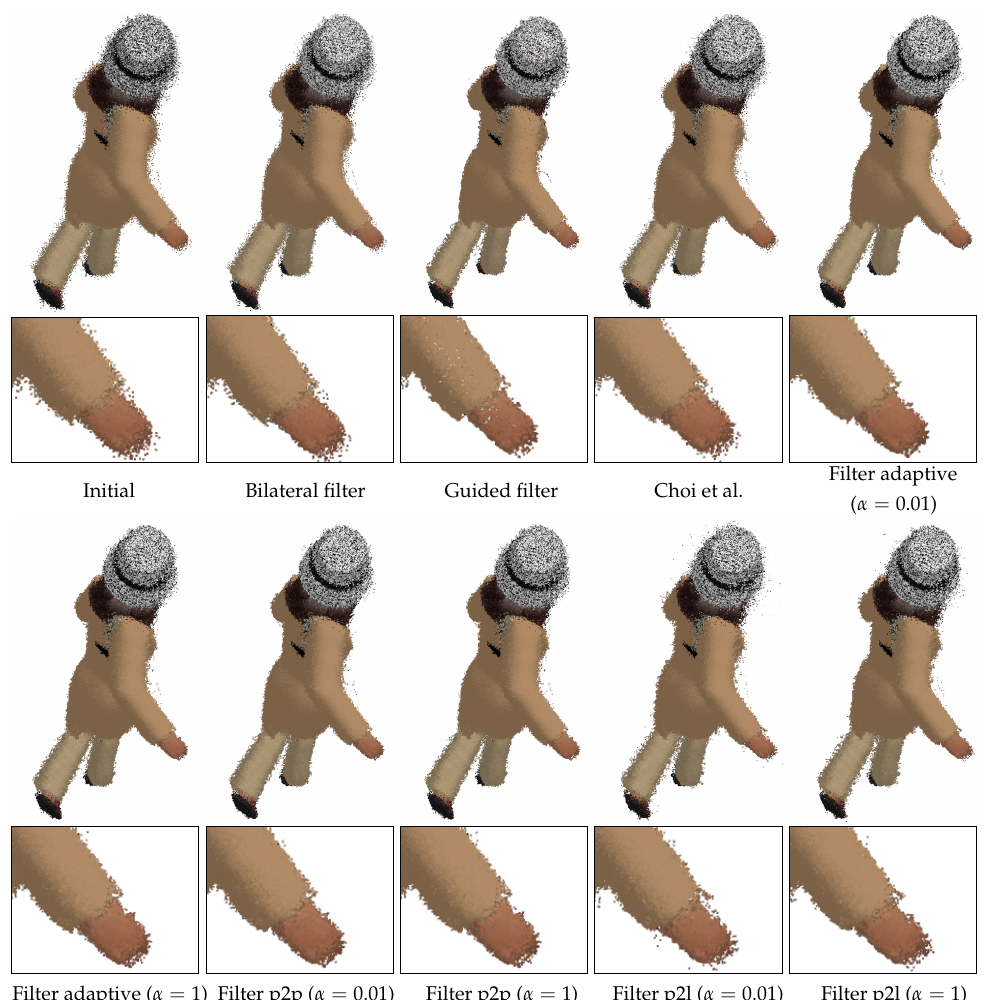
Figure 5. Point cloud rendering results. ( First and third rows ): Merged point clouds. ( Second and fourth rows ): Magnified hand regions. We note that neither a preprocessing nor a postprocessing method has been applied to the